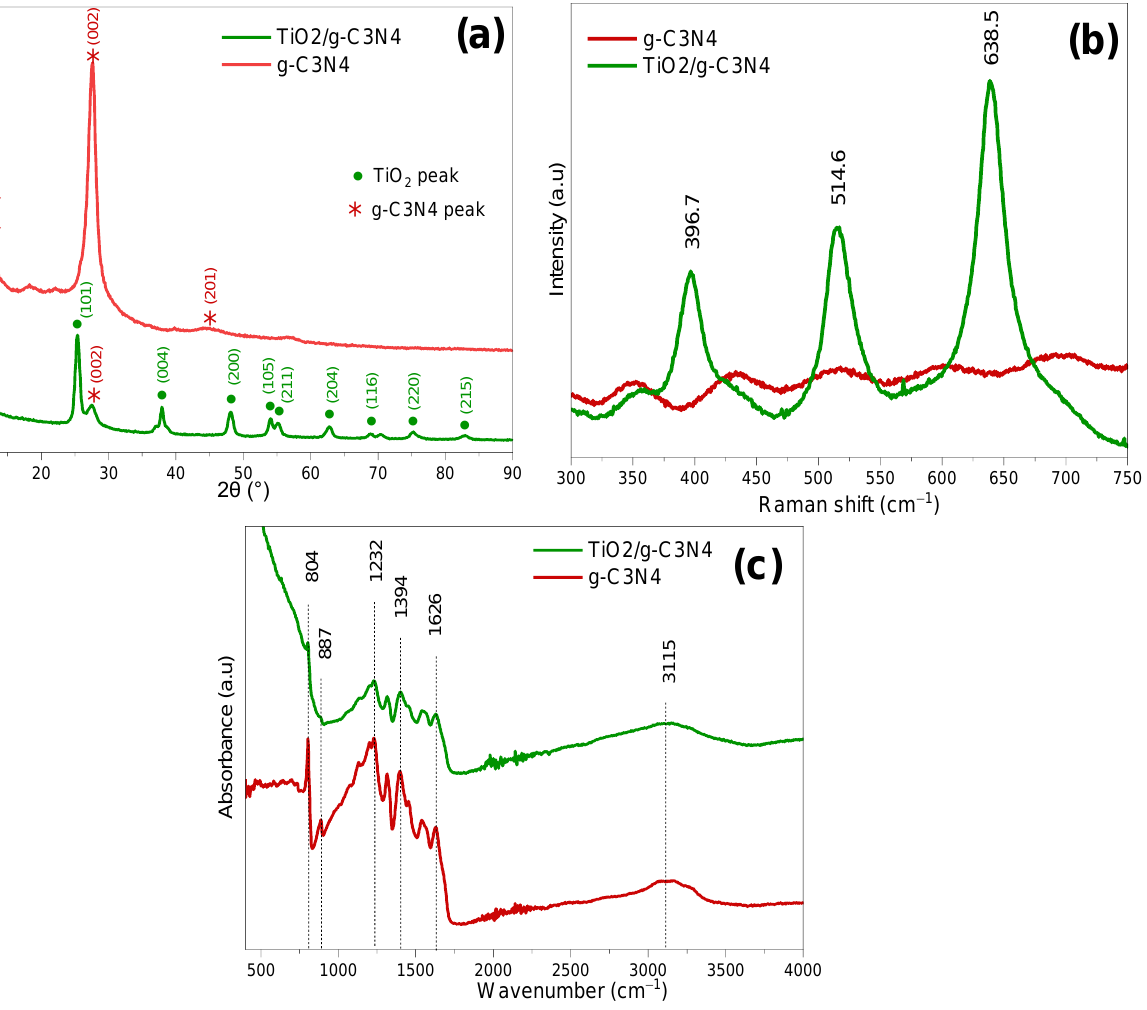
Figure 3. ( a ) XRD patterns of materials; ( b ) Raman spectra and ( c ) FTIR spectra of g-C 3 N 4 and TiO 2 /g-C 3 N 4 composites.